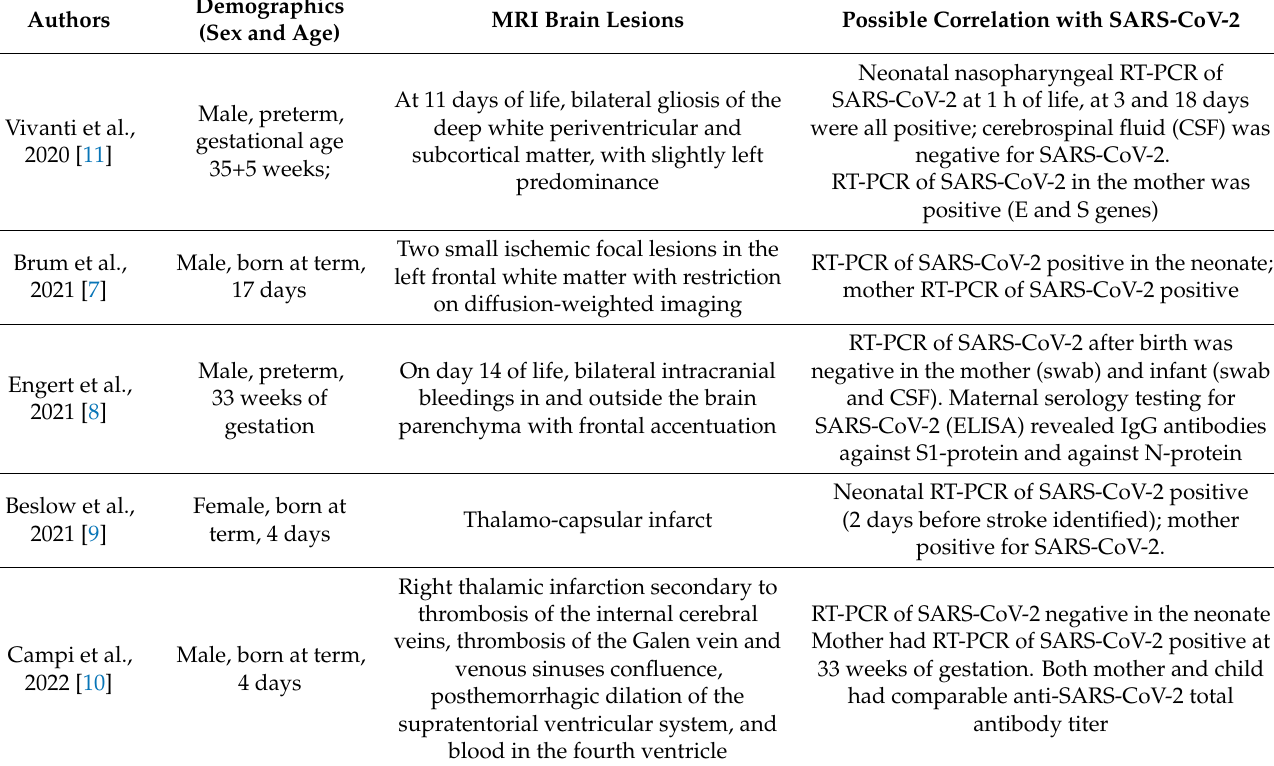
Table 3. Neonatal ischemic brain lesions correlated with SARS-CoV-2